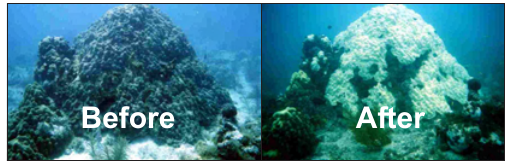
Figure 1. The effects of coral bleaching (Adapted from [3]).